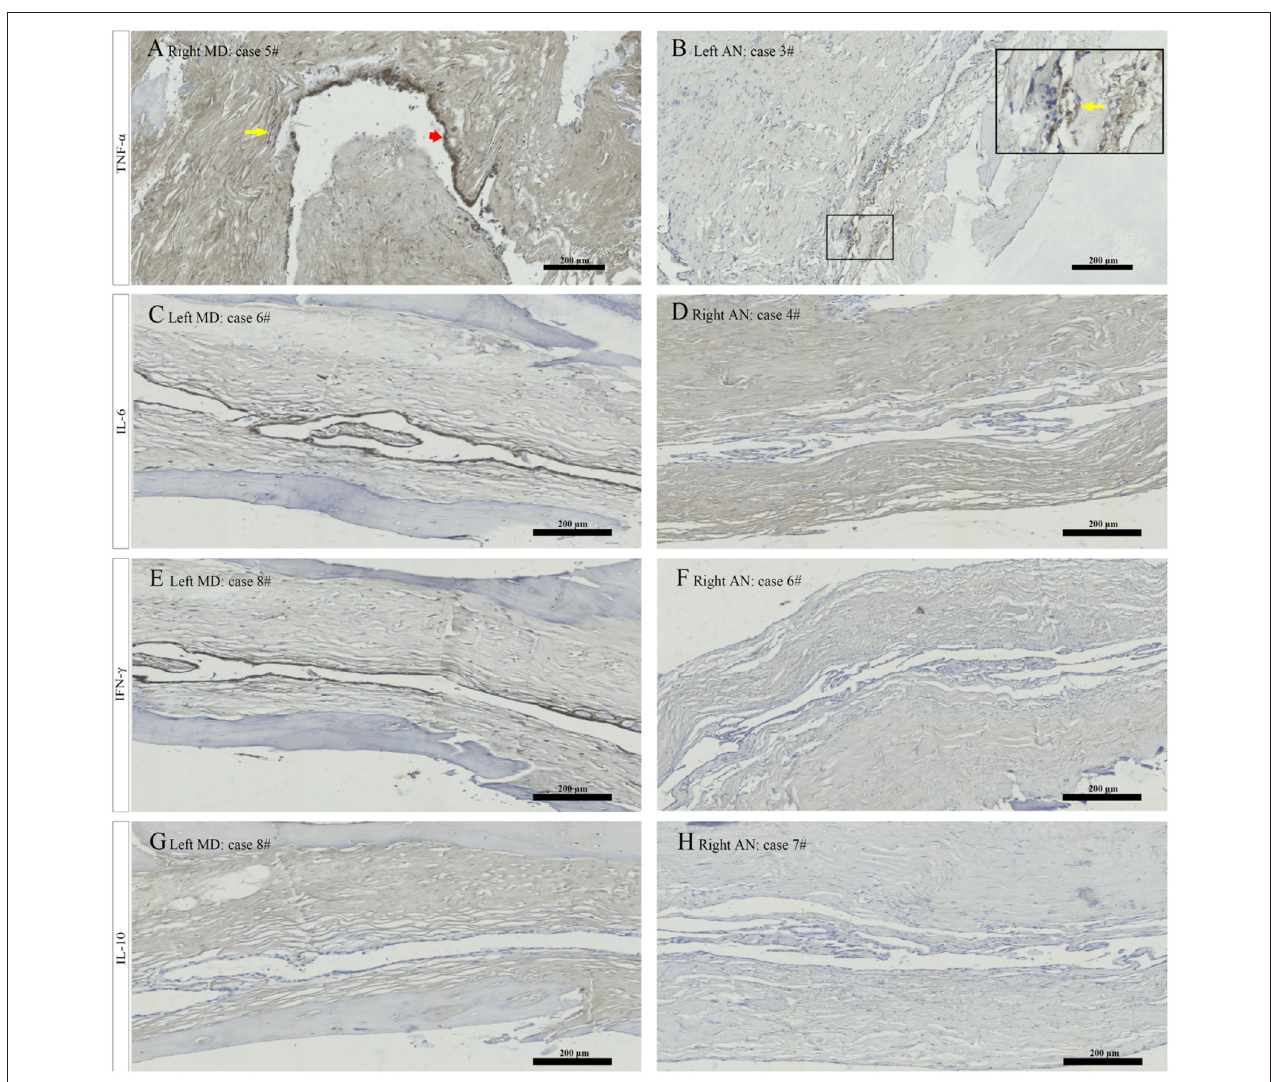
FIGURE 5 | Immunostaining for TNF α showed strong staining of epithelial cells (red arrowhead) and weak staining of the subepithelial fibroblasts (yellow arrow) in patient no. 5 with right MD (A) , and weak staining of epithelial cells in the magnified framed area (yellow arrow) in patient no. 3 with left AN (B) . Immunostaining for IL 6 revealed strong signal in the ES epithelium in patient no. 6 with left MD (C) and no positive expression of epithelial cells in patient no. 4 with right AN (D) . Immunostaining from ES specimen in patient no. 8 with left MD showed strong labeling along the epithelial lining of ES for IFN γ (E) and a negative expression in the epithelial cells of ES for IL-10 (G) . Whereas a negative expression of the ES epithelium for IFN γ in patient no. 6 with right AN (F) and IL-10 in patient no. 7 with right AN (H) were detected. MD, Meniere’s diseae; AN, acoustic neuroma; ES, endolymphatic sac. Scale bars: (A–H) 200 µ